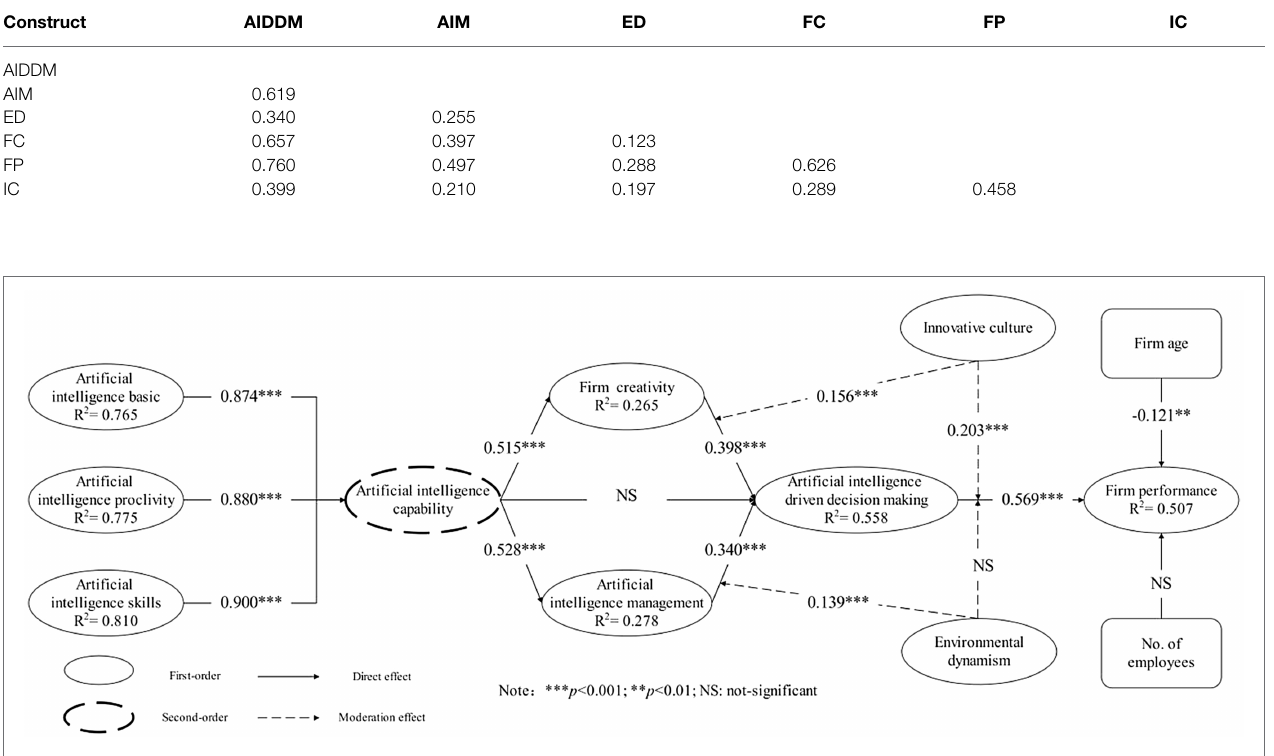
FIGURE 3 | Partial least squares structural equation modeling (PLS-SEM) results.